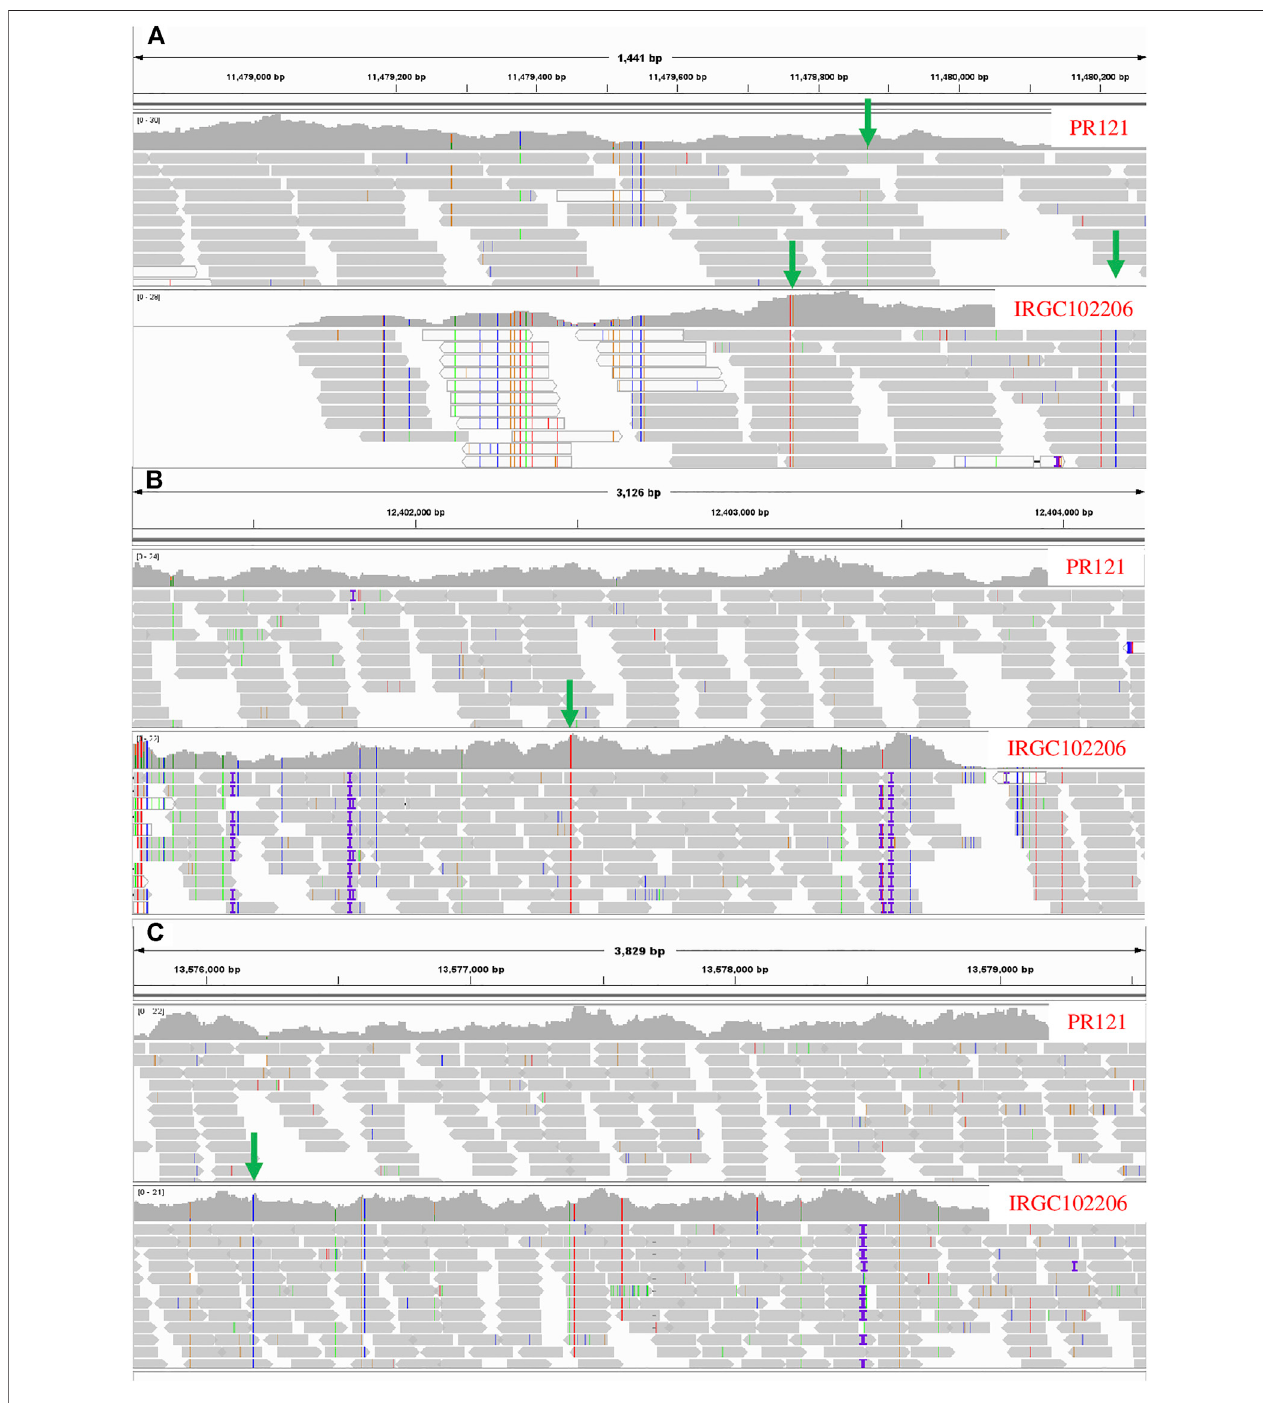
FIGURE 5 | Integrative Genome Viewer showing glycosyltransferase (BGIOSGA022727) (A) , peroxidase (BGIOSGA022766) (B) , and thioredoxin reductase (BGIOSGA021328) (C) candidate genes in the susceptible parent (PR121) and the resistant parent (IRGC102206). The non-synonymous SNPs are highlighted with green